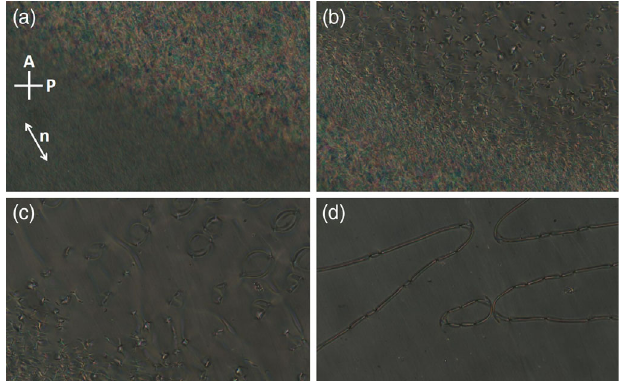
FIG. 3. Polarization microscopy images showing the N - N S phase transition during fast cooling in a planar cell (thickness 20 μ m). (a) Destabilization of the nematic order, (b,c) evolution of defects, and (d) defects in the N phase. The orientation of n , S the polarizer, and the analyzer are shown in (a). For better observations, the sample was rotated so that the angle between n and the analyzer was around 20°. The width of the images is 545 μ m.